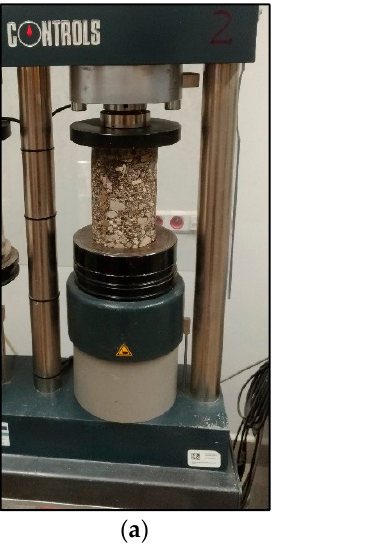
Figure 14. Results of the unconfined compressive strength tests on the samples from the REF-Mix and RCC-Mix mixtures as a function of specimen age.